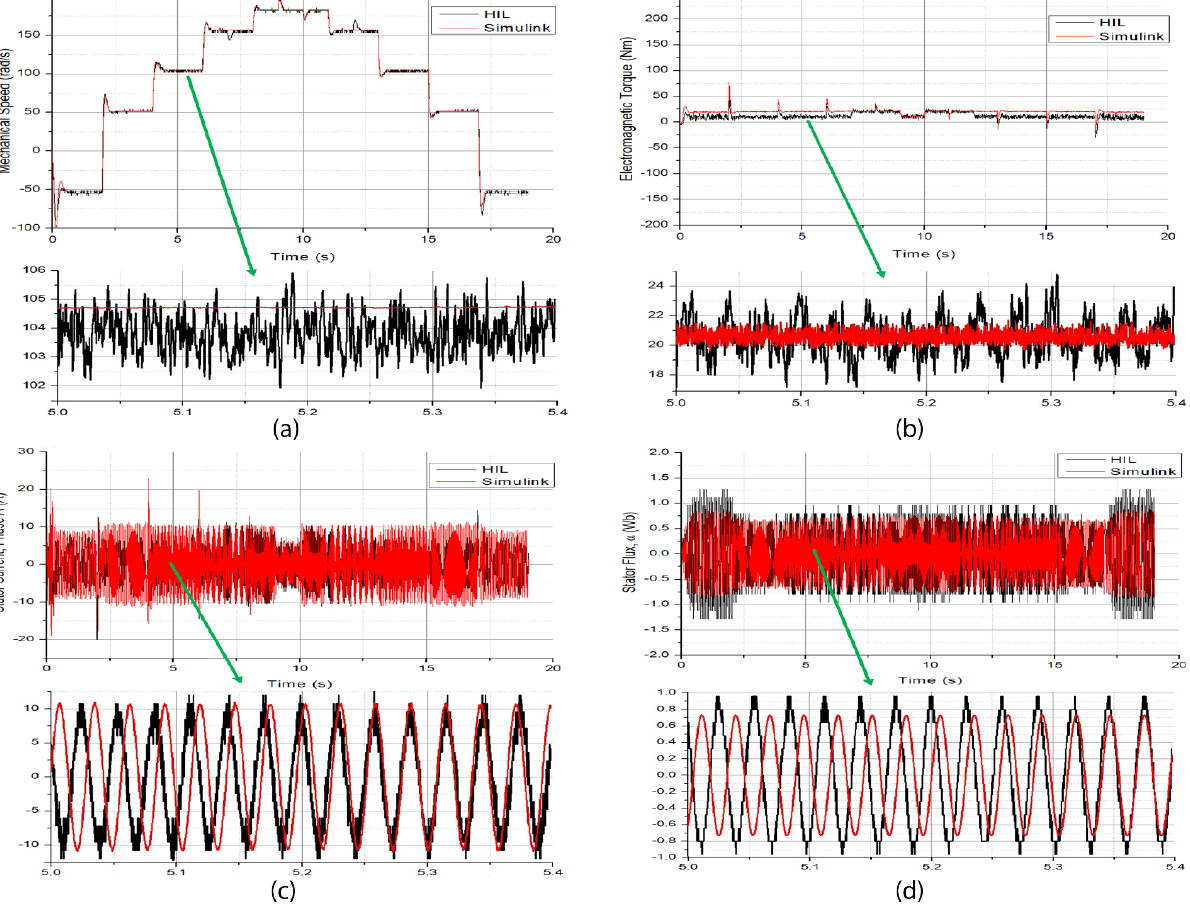
Figure 10. Numerical and practical results of the PCC variable speed controller: ( a ) speed; ( b ) torque; ( c ) stator current; and ( d ) stator